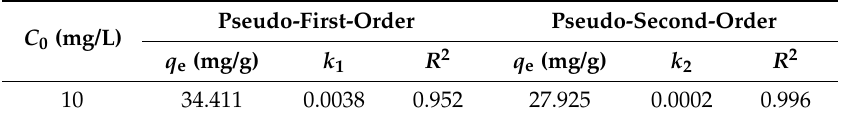
Table 3. The fitted parameters of the pseudo-first-order model and pseudo-second-order kinetic model of Hg(II) sorption on MPy-600.